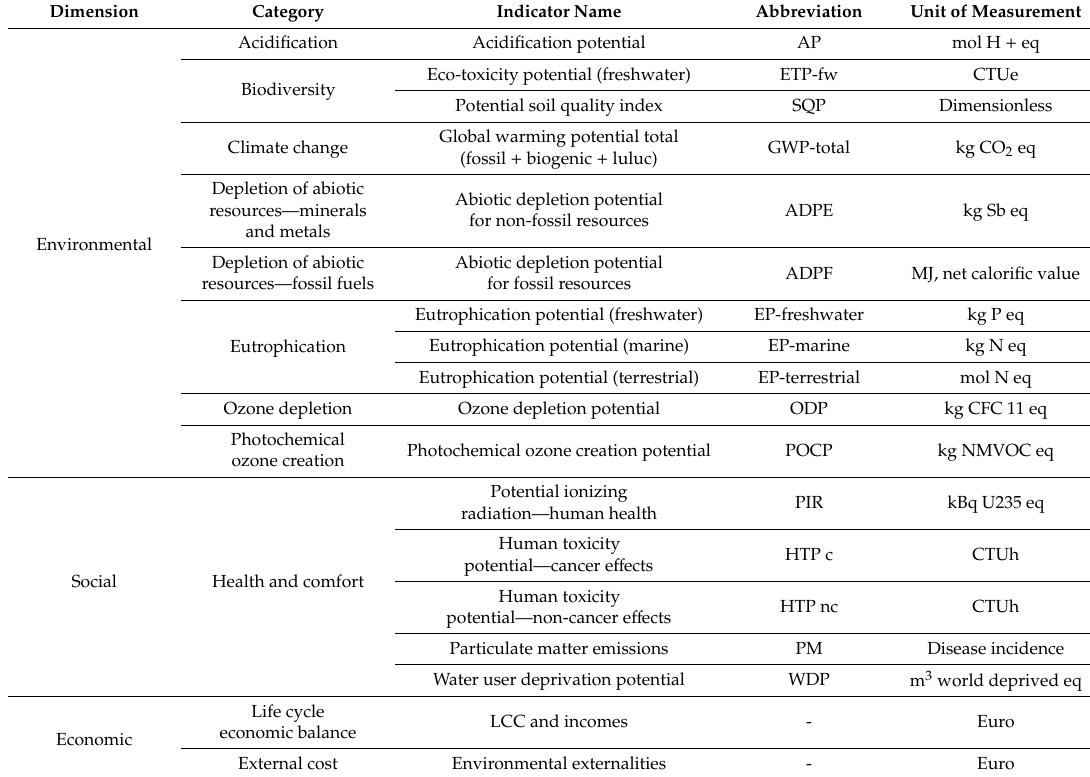
Table3. Sustainabilitydimensions, categories, indicatornames, abbreviations, andunitsofmeasurement for the